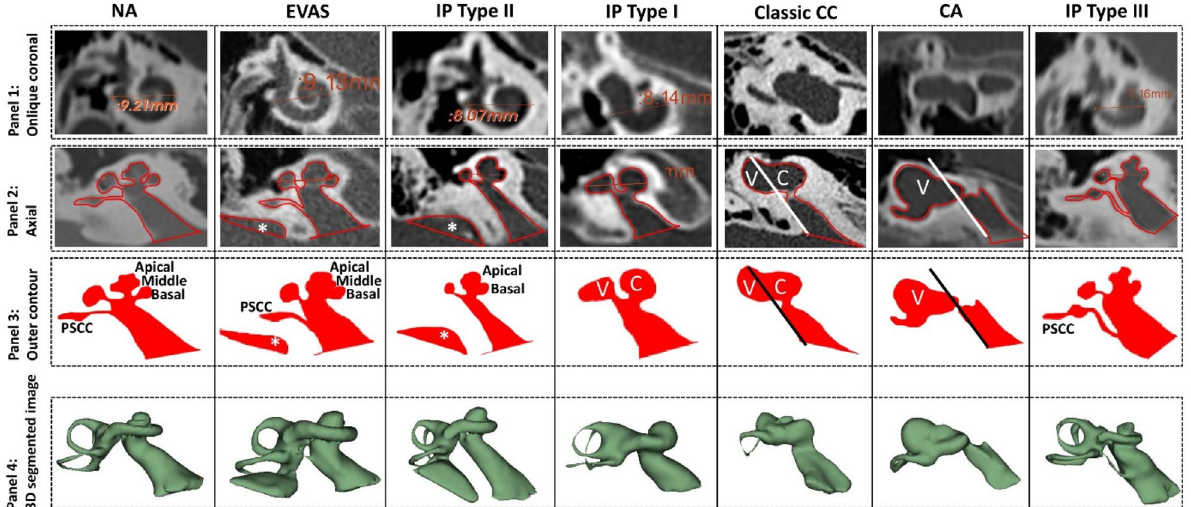
Figure 2. Sample data from every anatomical type in the oblique coronal view showing the A-values is shown in panel 1. Axial view showing the outer contour of the inner ear drawn manually (panel 2) and the captured outer contour filled with color (panel 3). The A-value is not measurable in the classic common cavity (CC) and vestibular cavity anatomical types. The straight line drawn parallel to the posterior edge of internal auditory canal differentiates the cochlear (C) from the vestibular portion (V) in classic CC and shows only the presence of V in the CA anatomical type. The asterisk (*) refers to the enlarged vestibular aqueduct seen in enlarged vestibular aqueduct syndrome (EVAS) and the incomplete partition (IP) type II. The 3D segmented image of the inner ear allows, performed following the procedure of Dhanasingh et al. 4 , gives a better understanding of how the inner ear structures look (panel 4). The 3D segmentation images are not to